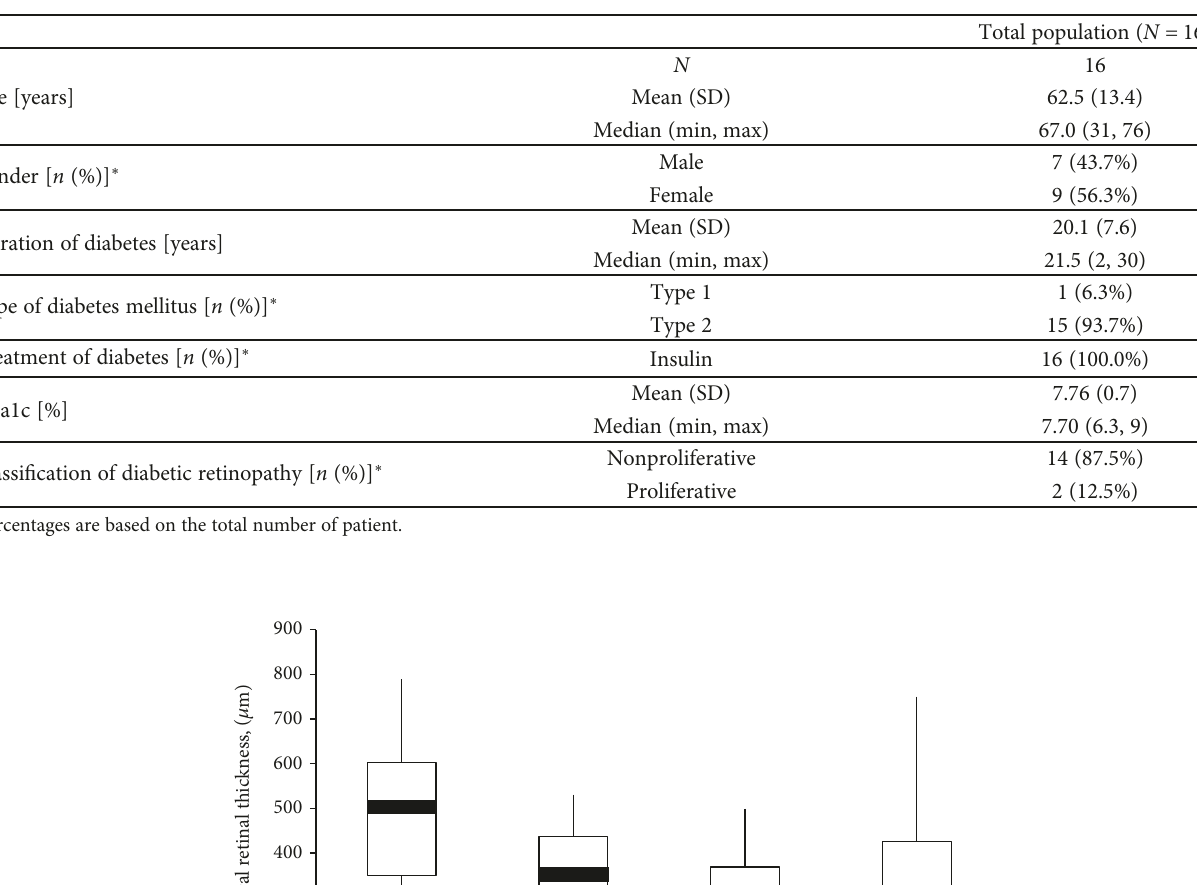
Table 1: Demographic characteristics and relevant medical history with regard to diabetes.